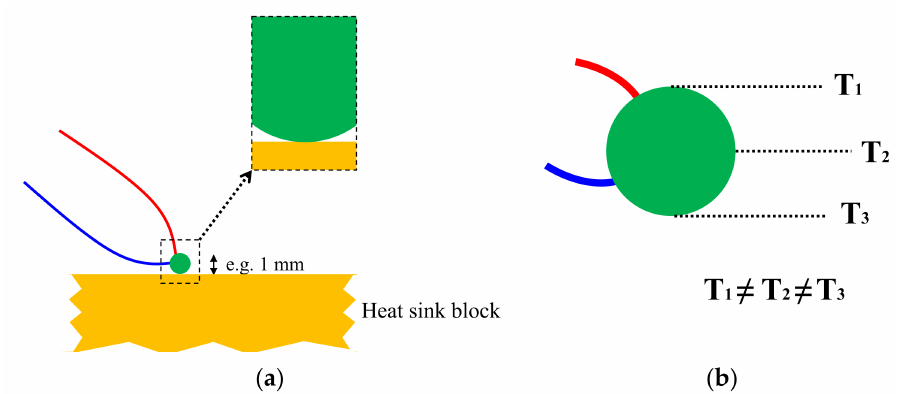
Figure 4. Thermoelectric junction: ( a ) wire thermocouple on the copper heat sink and zoom of the heat sink/weld contact area; ( b ) temperature distribution in the volume of a large thermoelectric